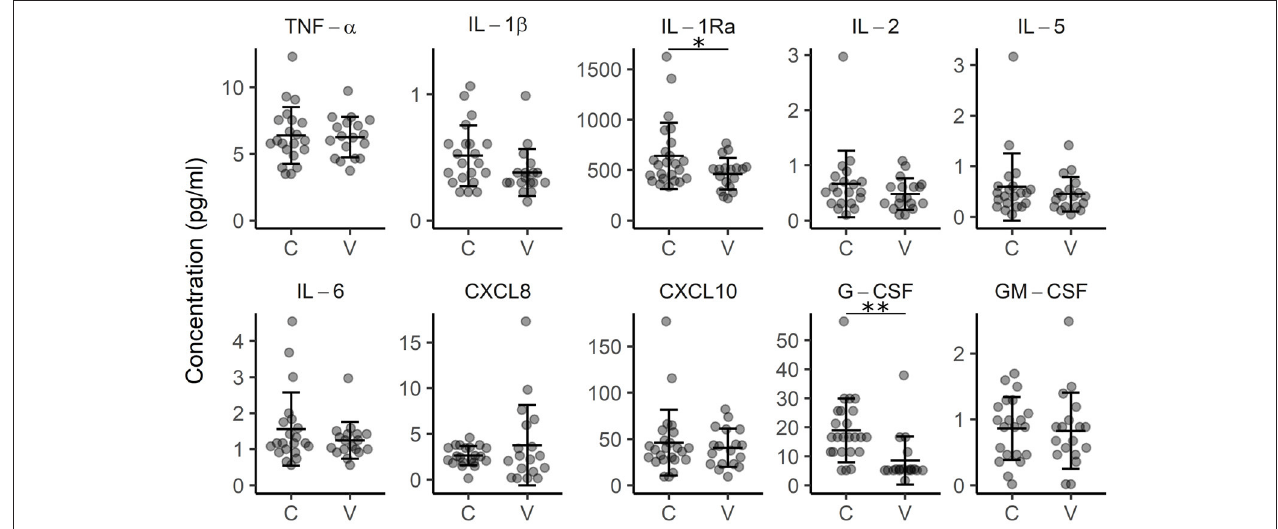
FIGURE 2 | Concentration of cytokines in the plasma of control subjects (C) and vitiligo patients (V). Arithmetic mean ± standard deviation is indicated. * p < 0.05; ** p <